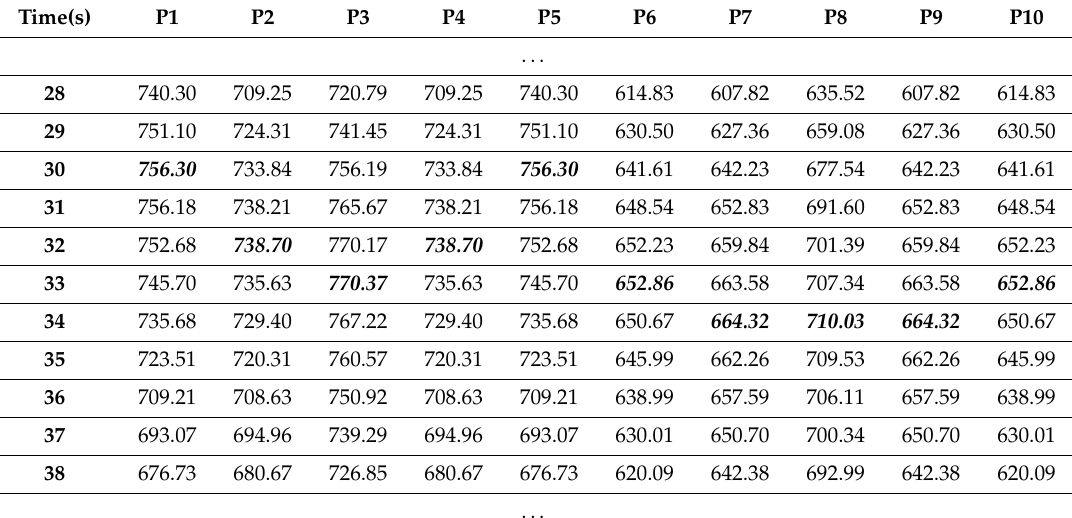
Table 11. Temperature change over the time on check points ( ◦